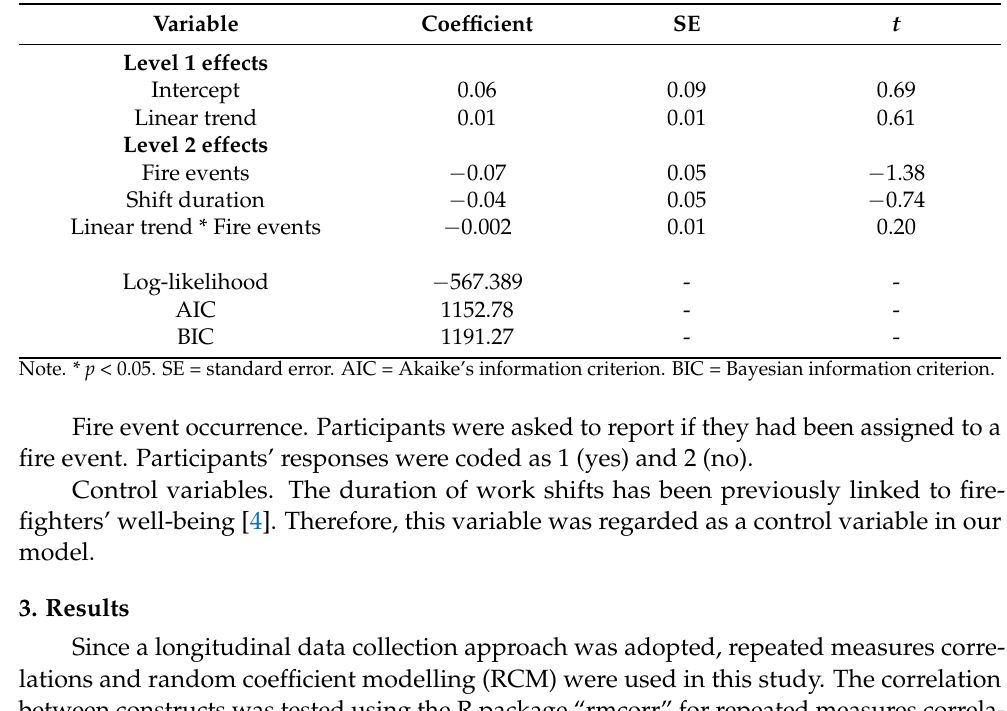
Table 1. Fire Event Occurrence Predicting Change in Work